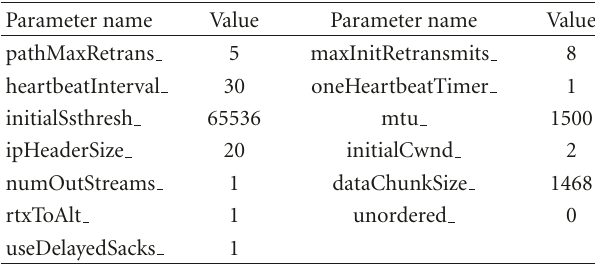
Table 1: Parameters of